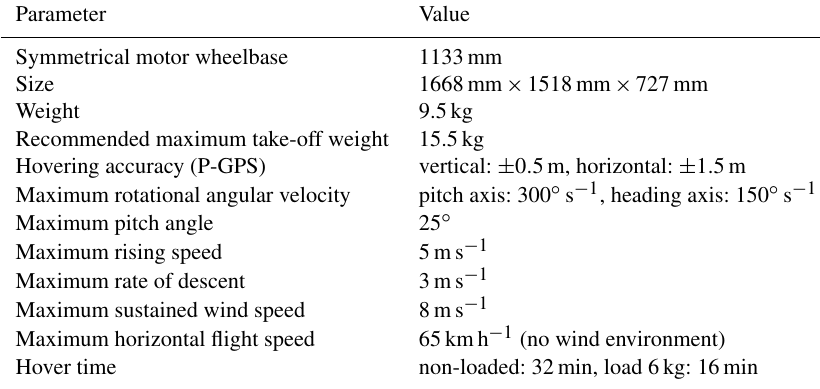
Table 1. Parameters of the